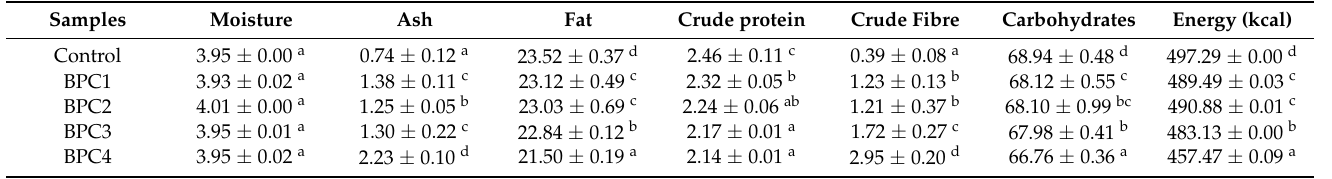
Table 4. Proximate composition of biscuits in 100